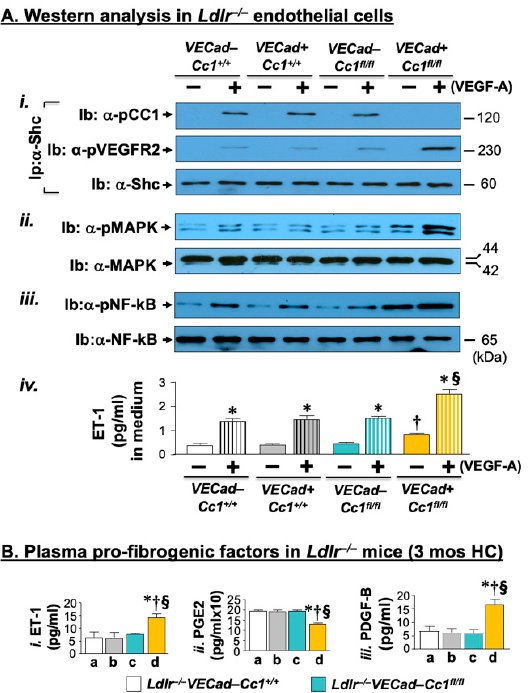
Figure 3. VEGF-A signaling through the Shc/MAP kinase pathway in primary endothelial cells. ( A ) Endothelial cells were isolated from the hearts of 2-month-old mice ( n ≥ 5/genotype) and treated with (+) or without (–) VEGF-A (40 ng/mL) for 5 min. (i) Lysates were subjected to immunoprecipi- tation (Ip) with α -Shc antibody followed by immunoprobing with antibodies against Shc, phospho- CEACAM1 (pCC1), and phospho-VEGFR2 (pVEGFR2) to evaluate the level of these proteins in the α -Shc immunopellet. (ii–iii) Lysates were subjected to immunoblotting with α -phospho-antibodies against phosphorylated MAPK and NF- κ B and in parallel gels, against MAP Kinase (MAPK), and NF- κ B protein for normalization. (iv) Endothelin-1 (ET-1) was assayed in the media of isolated en- dothelial cells stimulated with VEGF-A for 20 min. Values were expressed as mean ± SEM. * p < 0.05 vs. no VEGF-A (solid bars)/same genotype; † p < 0.05 vs. (–) VEGF-A in all 3 controls; § p < 0.05 (+) VEGF-A (vertical lines) in all 3 controls. ( B ) Retro-orbital venous blood was drawn from overnight fasted mice fed HC for 3 months ( n ≥ 5/genotype) to analyze plasma (i) ET-1, (ii) PGE2, and (iii) PDGF-B. Values were expressed as mean ± SEM. * p < 0.05 vs. Ldlr − / − VECad–Cc1 +/+ (a, white bar); † p < 0.05 vs. Ldlr − / − VECad+Cc1 +/+ (b, grey bar); and § p < 0.05 vs. Ldlr − / − VECad–Cc1 fl/ fl (c, teal bar). As expected from IL-6 activation of STAT3 (signal transducer and activator of tran- scription 3), Ldlr − / − VECadCre+Cc1 fl/fl aortae exhibited higher basal STAT3